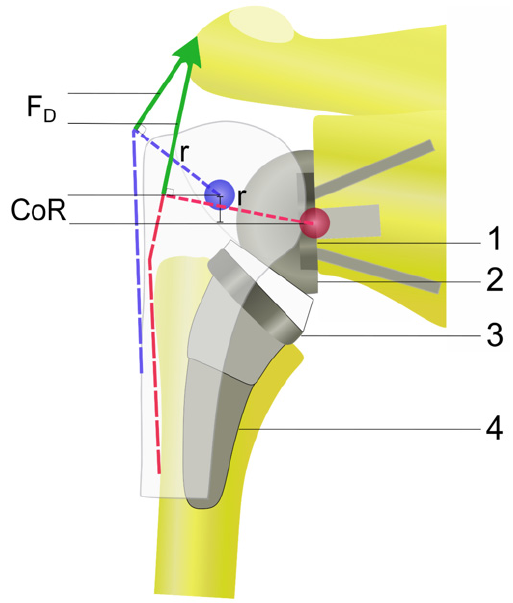
Figure 1. Illustration of biomechanical properties in native joint and reverse total shoulder arthro- plasty. Relative to the normal anatomy, the center of rotation (CoR) is shifted medially and inferiorly, thus lengthening the moment arm (r) and increasing the deltoid force (F D ). 1: glenoid baseplate; 2: glenosphere; 3: metaphyseal component; 4: humeral stem.